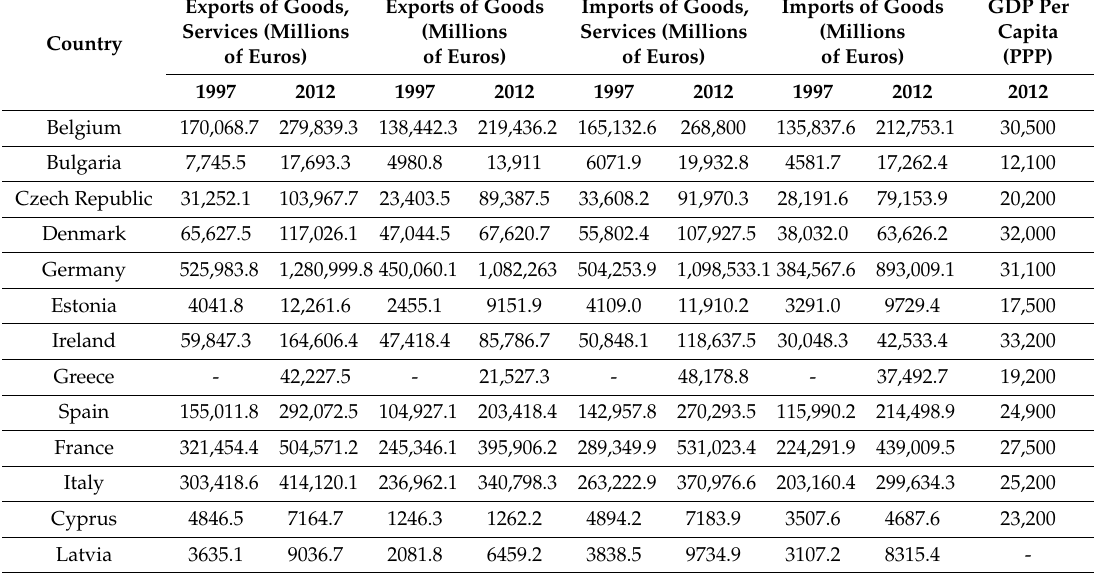
Table 2. Descriptive. Imports and exports of goods and services and GDP per